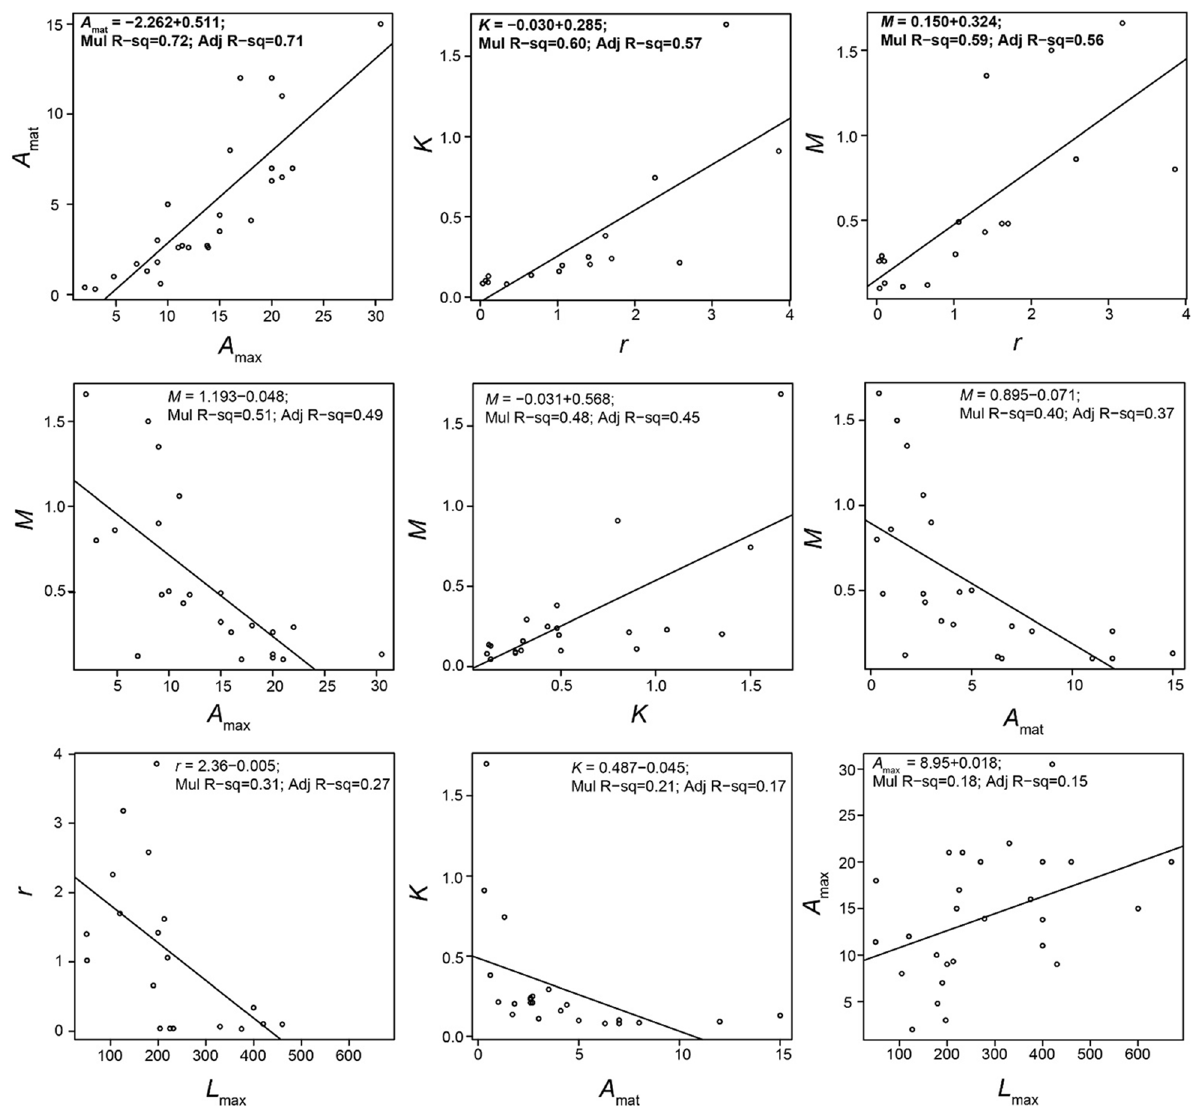
Fig. 3. Linear regressions of productivity attribute pairs with corresponding equations. Multiple R -square value (Mul R -sq) and adjusted R -square value (Adj R -sq) shown for each model fi t. Bold equations indicate correlated attribute